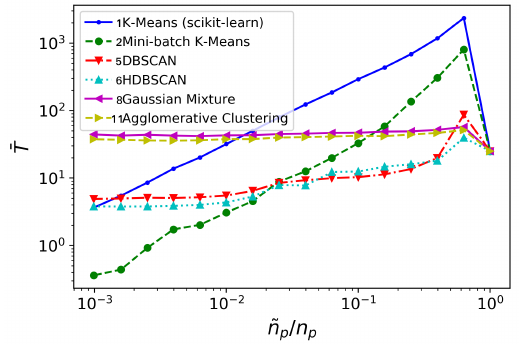
Figure 10. Re D = 60 cylinder flow: time invested (in seconds), for different clustering algorithms (averaged over 10